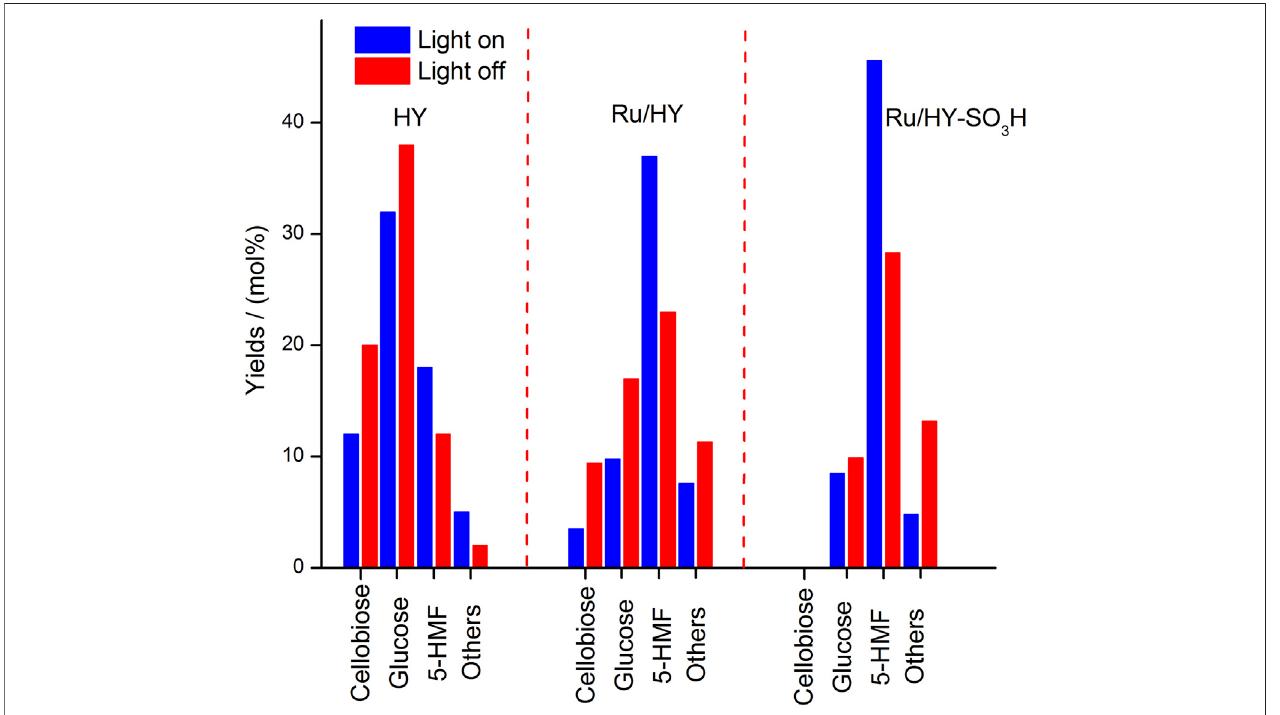
FIGURE 9 | Performance on cellulose conversion over zeolite catalysts (Ru/HY-SO 3 H, Ru/HY, and HY) with/without light irradiation in a biphasic system.